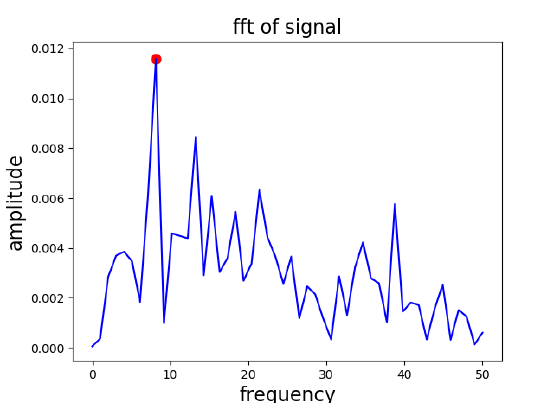
Figure 4. FFT of the primary vector of the SVD extracted from the two-second strongest portion of the earthquake